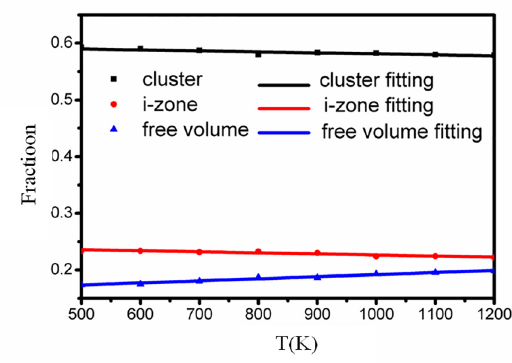
Figure 15. Changes of the relative fractions of cluster, i-zone and free volume atom pairs with temperature in AIMD simulations. 132